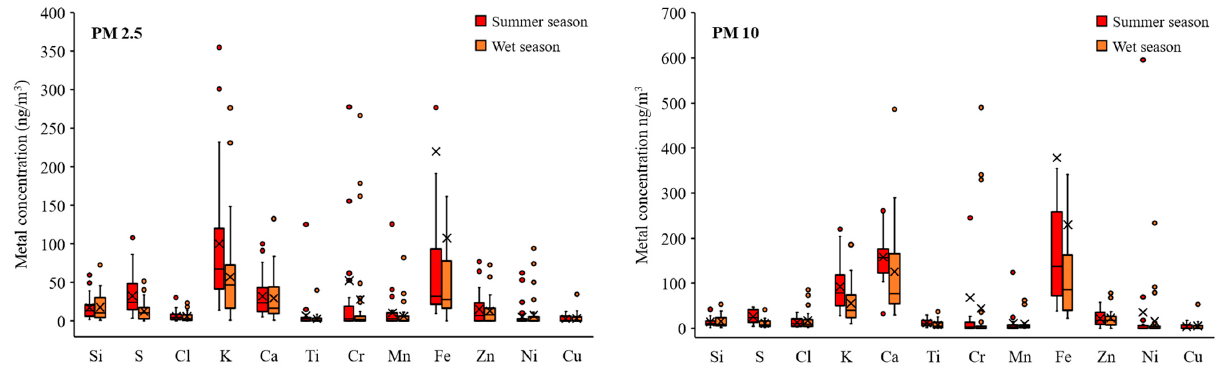
Figure 4. Metals concentration variations of PM 2.5 and PM 10 in summer and wet seasons. The line in the box represents the median, the cross shows the mean values, the bottom and top of the vertical lines represent the values of the 5th and 95th percentiles, respectively, the dot denote the data beyond the mean values). Table 6. Pearson’s correlation coefficients relating the mass of PM 2.5 and the elements concentrations of PM 2.5 .